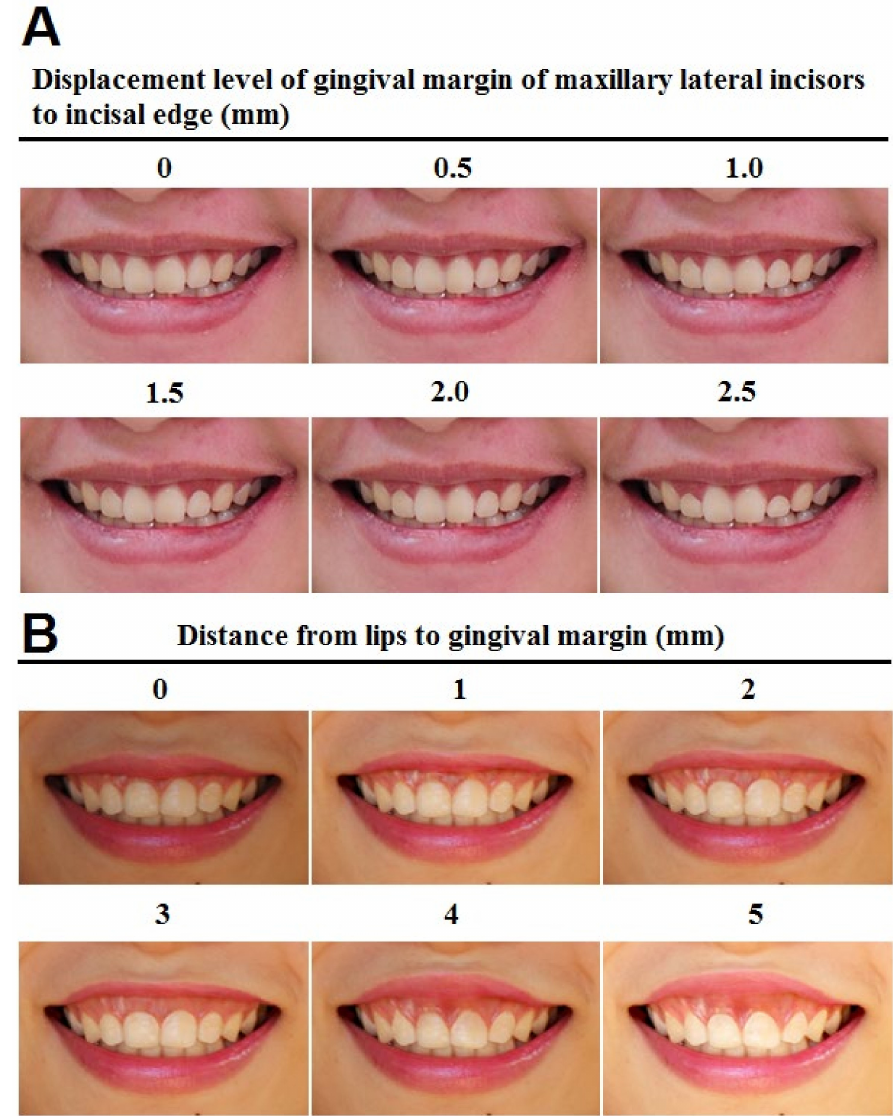
Figure 2. Modification on gingival margin position of maxillary lateral incisors ( A ), and on gingival exposure level ( B